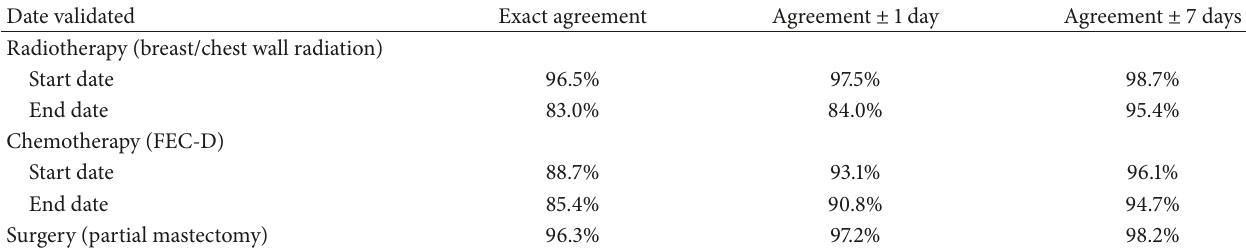
Table 4: Percent agreement between medical charts and administrative databases for radiotherapy, chemotherapy, and surgery